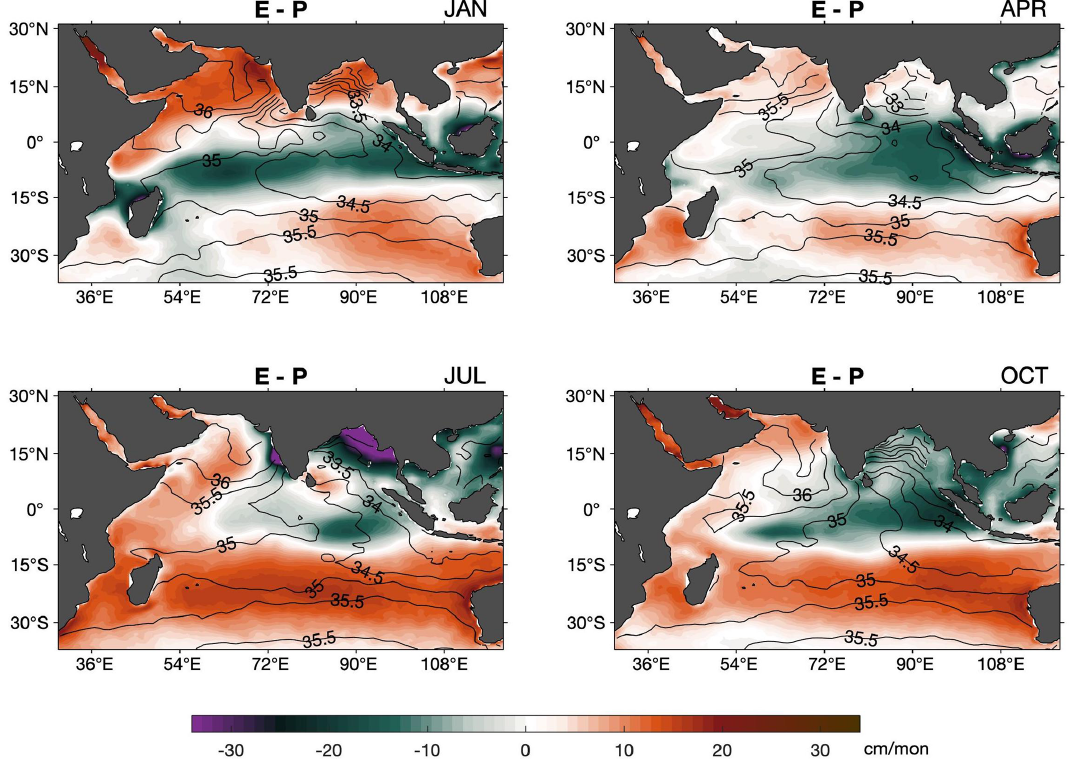
Figure 4. Climatology (2001–2018) of evaporation minus precipitation (colour shaded; positive values denote freshwater leaving the ocean and negative values addition of fresh water to the ocean) and sea surface salinity (black contours) for (a) January – NE monsoon, (b) April – transition, (c) July – SW monsoon, and (d) October – transition (adapted from Yu,